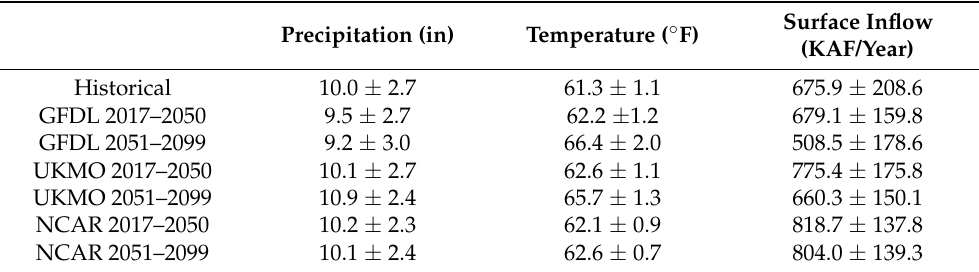
Table 1. Climate inputs for scenario tests with average values of periods 2017–2050 and 2051–2099 (Units of surface inflow are in thousands of acre-feet, KAF). Precipitation (in) Temperature ( ◦